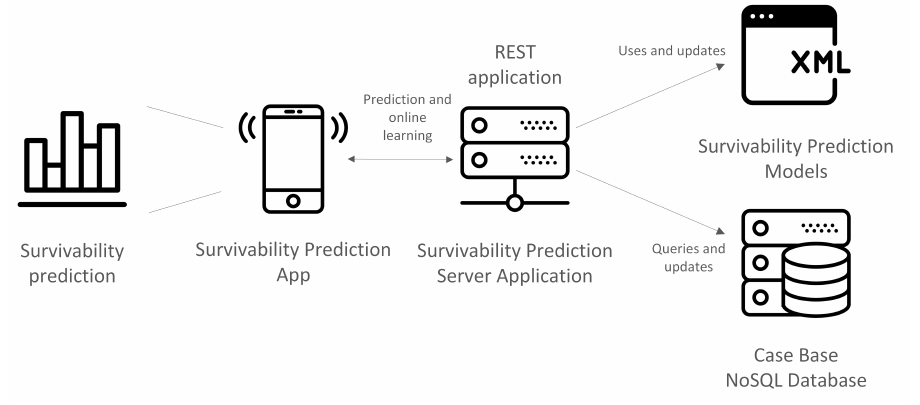
Figure 2. Architecture of the CRCPredictor